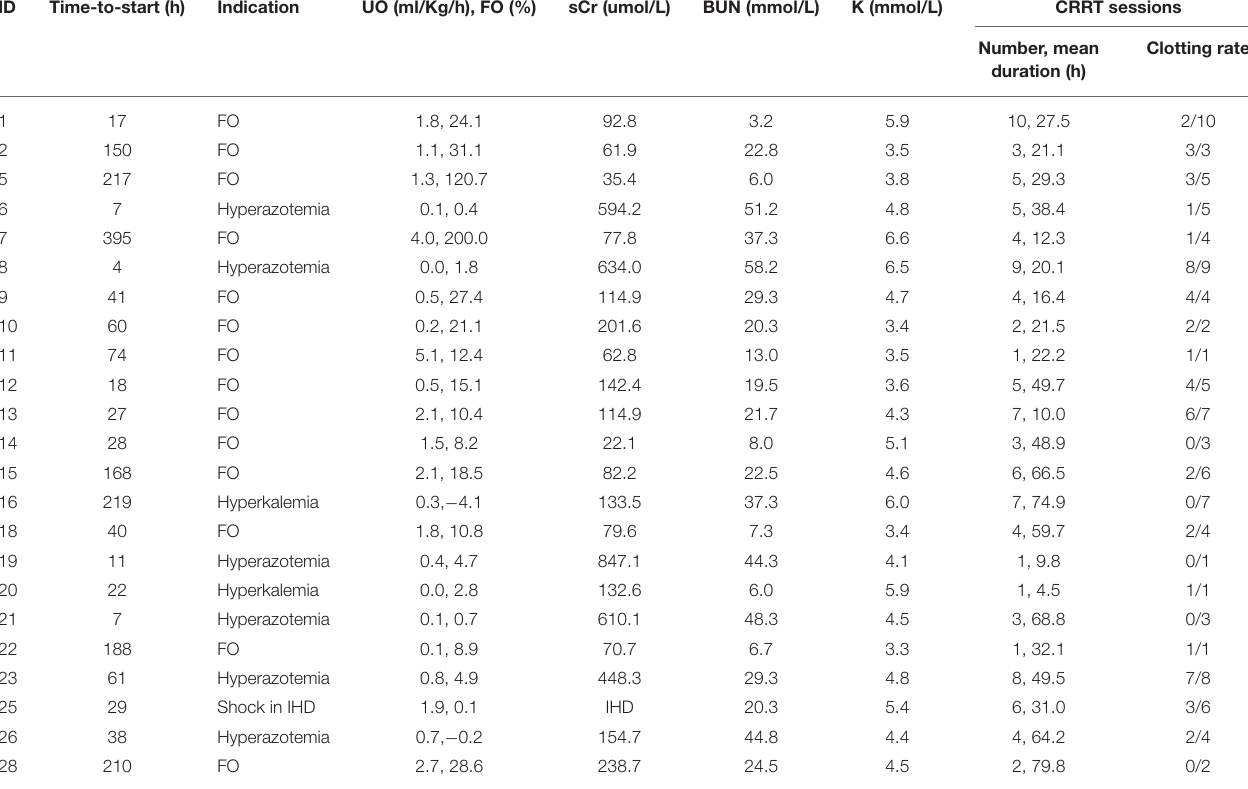
TABLE 2 | Clinical and biochemical characteristics at continuous renal replacement therapy initiation; number, duration, and clotting rate.